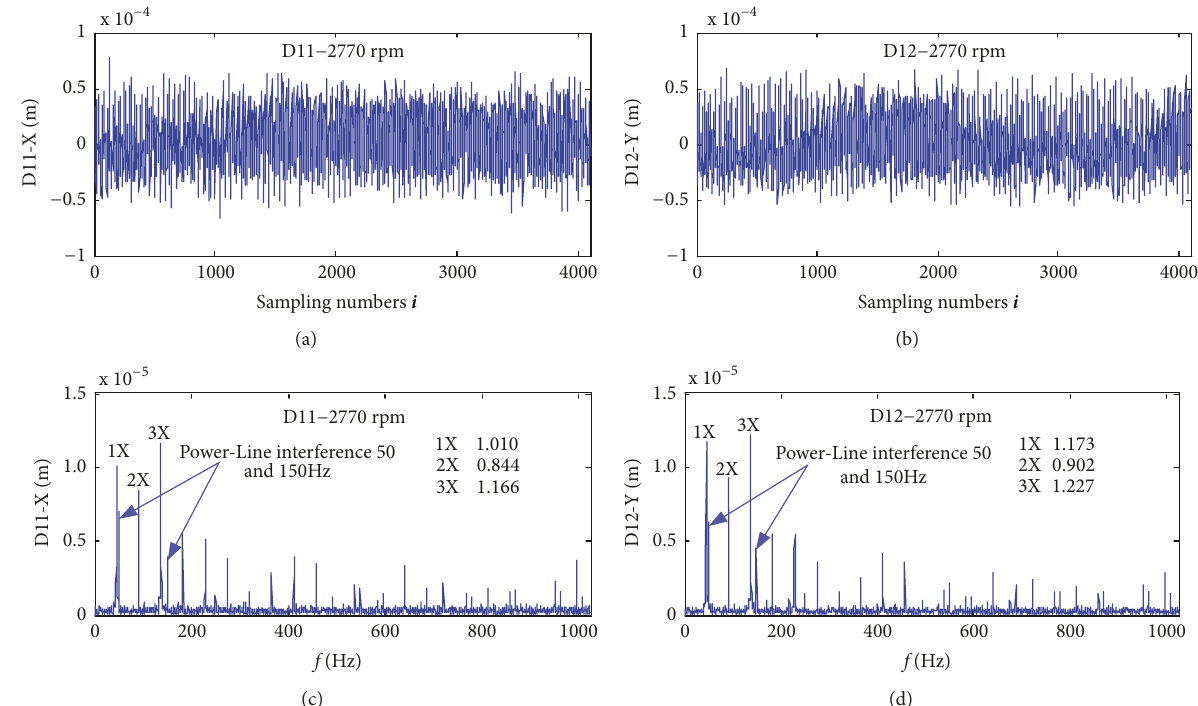
Figure 14: The time and frequency domains of the D11 and D12 sensors. (a) The time domain of D11. (b) The time domain of D12. (c) The frequency domain of D11. (d) The frequency domain of D12.